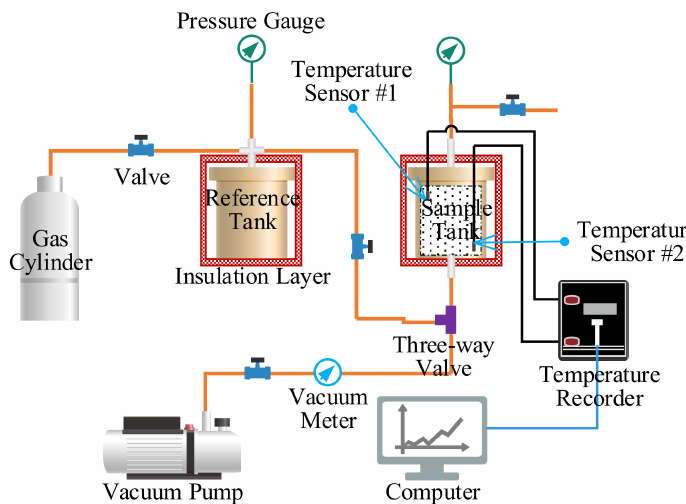
Figure 1. Adsorption experimental